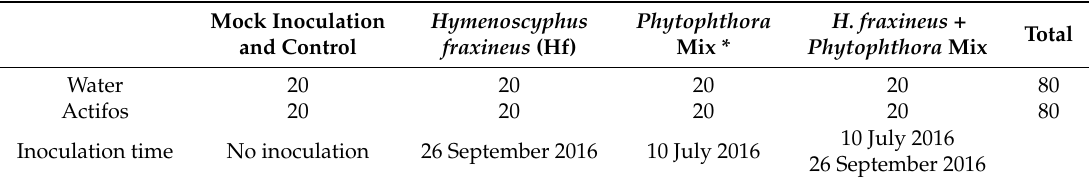
Table 1. Experimental design of three-year-old European ash